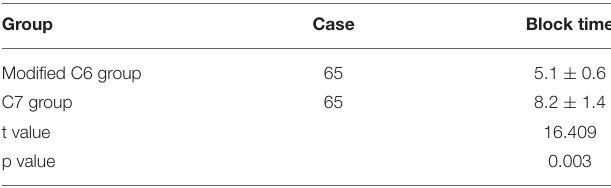
TABLE 2 | Comparison of block time between the two groups ( x ± s,min).